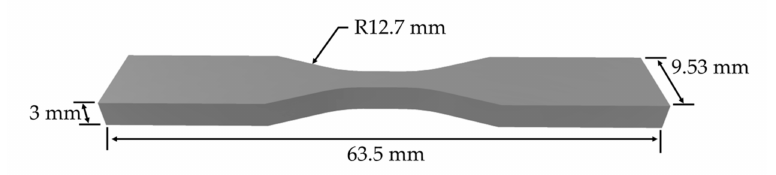
Figure 2. Tensile test